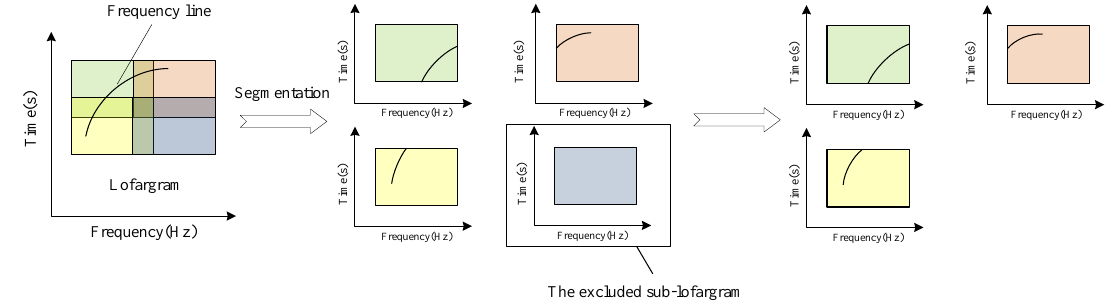
Figure 4. The segmentation of lofargram and sub-lofargram screening.